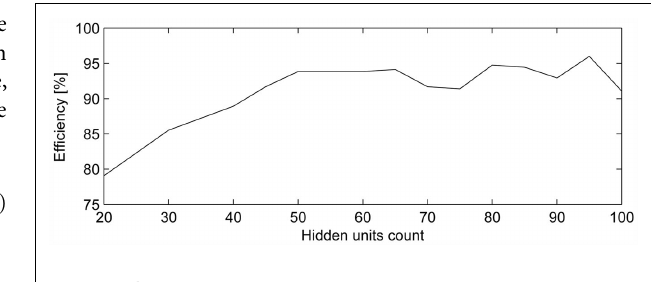
FIGURE 6 | Network accuracy on the testing data as a function of the hidden-layer